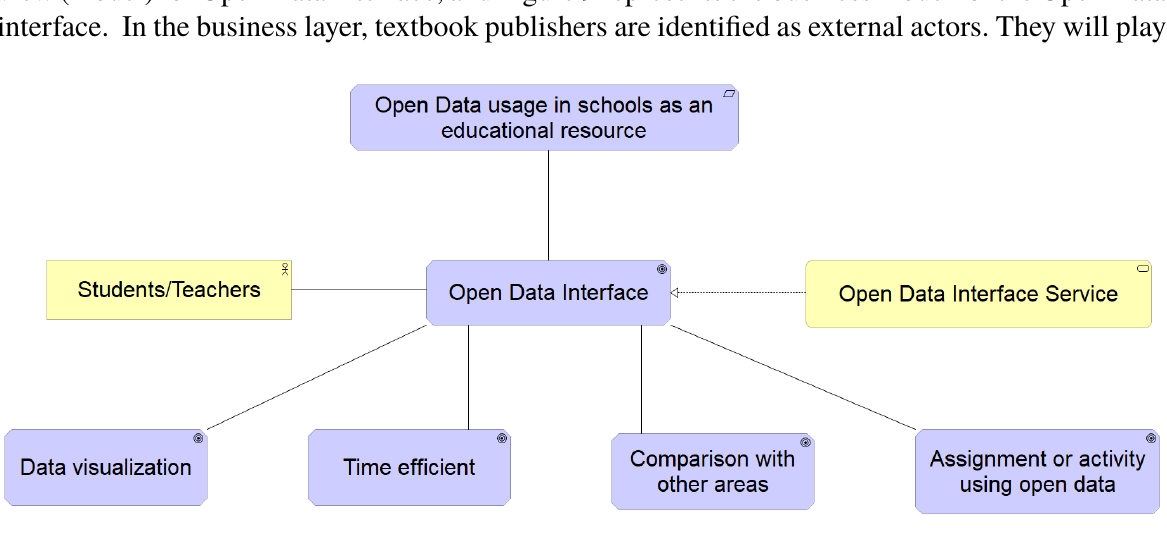
Figure 8. Open Data web interface usage view